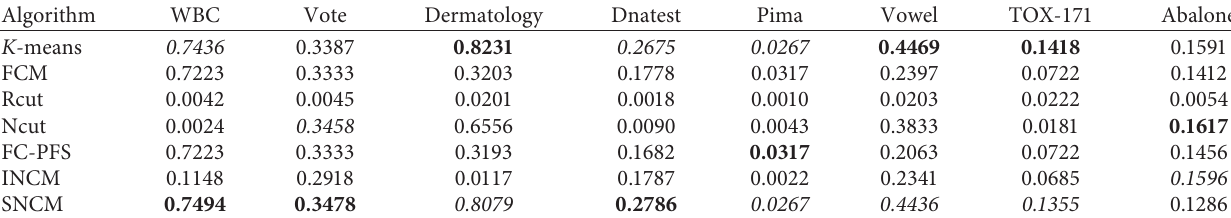
Table 7: NMI comparison of different algorithms under different data sets.